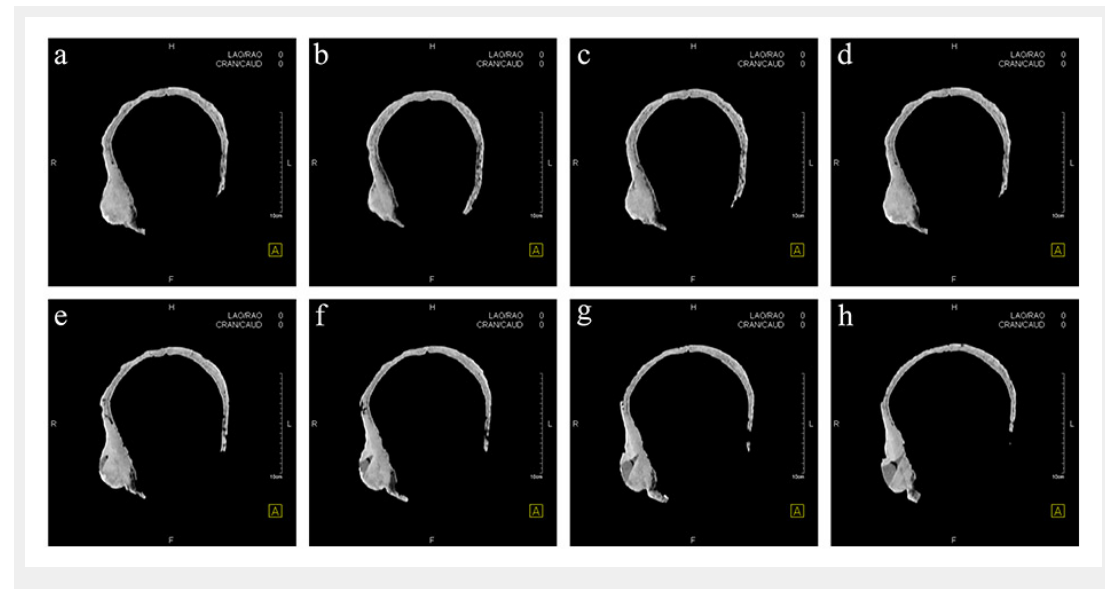
Figure 5 Horizontal computed tomography cross-sections of the skull. Selected representative